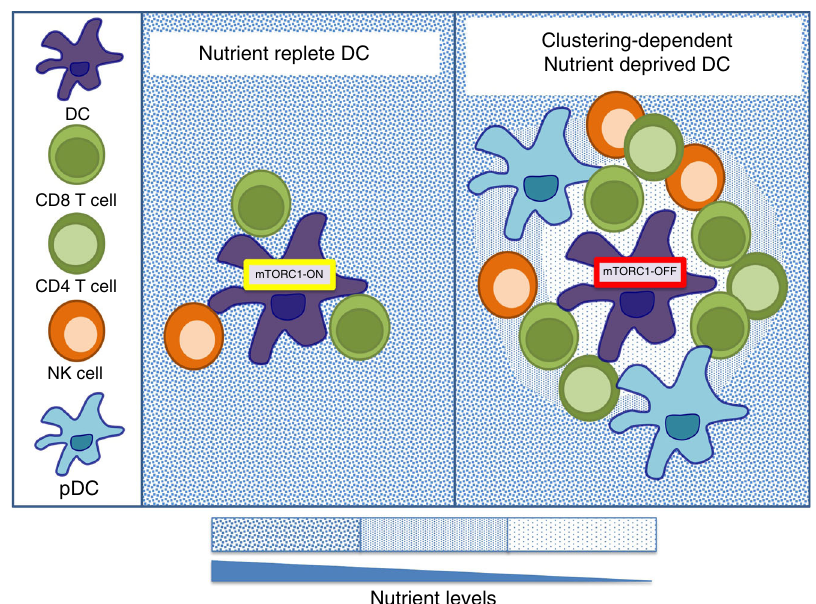
Fig. 3 Competition for nutrients between immune cells. Antigen-presenting dendritic cells (DC) can be found at the centre of cell clusters consisting of numerous different types of activated immune cells, including CD8 T cells, CD4 T cells, NK cells and plasmacytoid dendritic cells (pDC), with elevated nutrient uptake rates that will compete for nutrients (blue dots). Depending on the number of clustering cells surrounding an antigen-presenting DC, nutrients may be available (left panel) or depleted (right panel) in the immediate surrounding microenvironment due to competitive uptake. Nutrient starvation will have consequences for the DC including the inactivation of mTORC1 signalling, which has been linked to increased proin fl ammatory